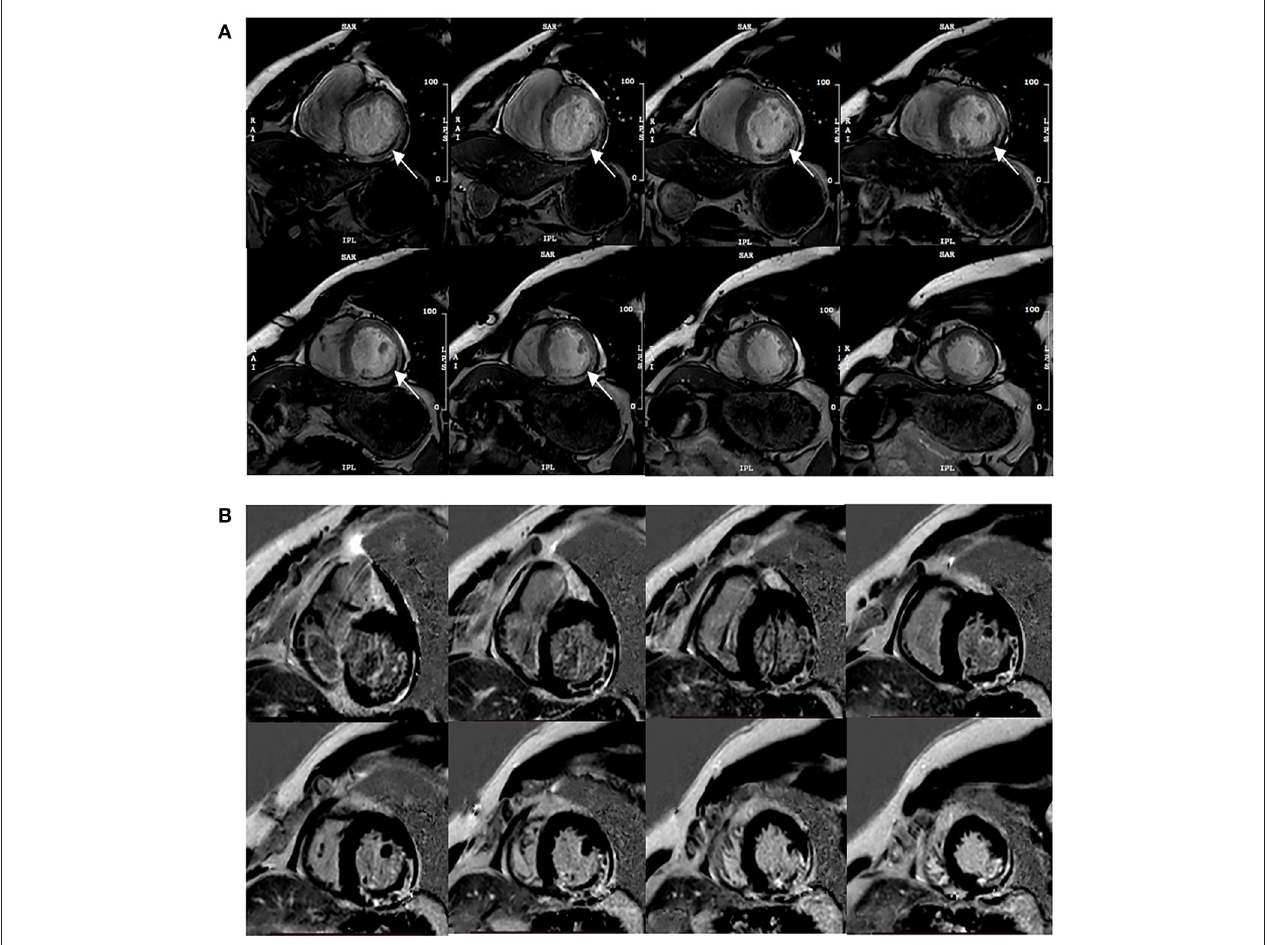
FIGURE 1 | Typical MVO appearance on contrast-enhanced cine (CE-SSFP) imaging at the same slice position during the cardiac cycle (A) , and the corresponding LGE images (B) . Arrows point to the dark area surrounded by the hyperintensity infarction zone constantly visible and located at the same position within the cardiac wall on each SSFP image during the cardiac